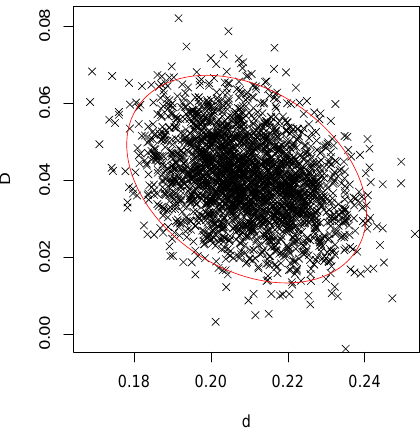
Figure 15. Joint posterior samples of ( d , D ) with 95% credibility set in red for CET time